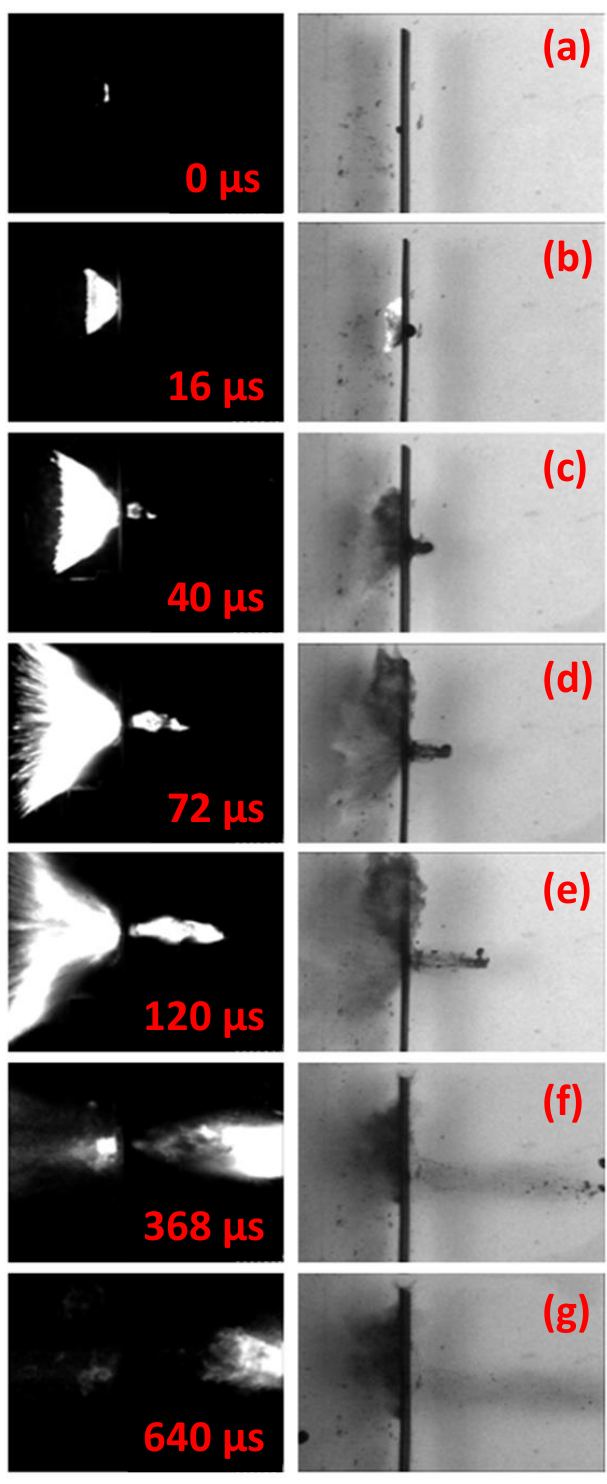
Figure 14. Time evolution of high-velocity impact for 5 mm MRE fragments impacting 2.5 mm plates. Left: energy release at impact velocity 1252 m/s. Right: impact velocity 1220 m/s. ( a ) impact between fragment and target, ( b ) interaction between the fragments and the targets and plug formation; ( c ) plug ejection; ( d – g ) plug flight behind the plate, debris cloud spreading and post-perforation energy release